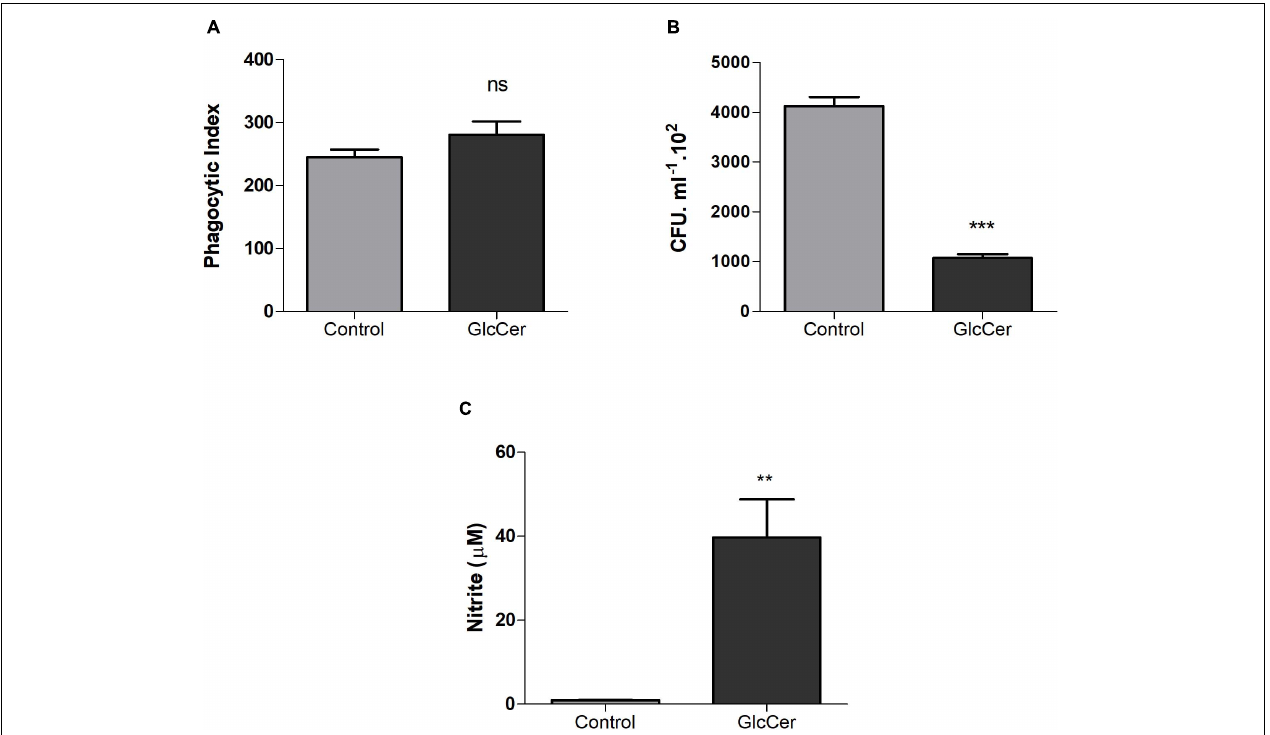
FIGURE 6 | Microbicidal activity of macrophages. (A) Phagocytosis of the L. prolificans conidia by macrophages previously activated or not by GlcCer species in vivo (200 µ g/100 µ l i.p.). (B) Microbicidal capacity of macrophages previously activated or not by GlcCer species in vivo (200 µ g/100 µ l i.p.) and incubated for 2 h with conidia of L. prolificans . After this incubation the macrophages were lysed and the supernatant was plated on solid Sabouraud. The CFU count was performed after 48 h. (C) NO production by macrophages previously activated or not by GlcCer species in vivo (200 µ g/100 µ l i.p.). Data are the mean ± SEM of duplicate samples from four independent experiments. ∗∗ p < 0.001; ∗∗∗ p < 0.0001; ns, no significant.